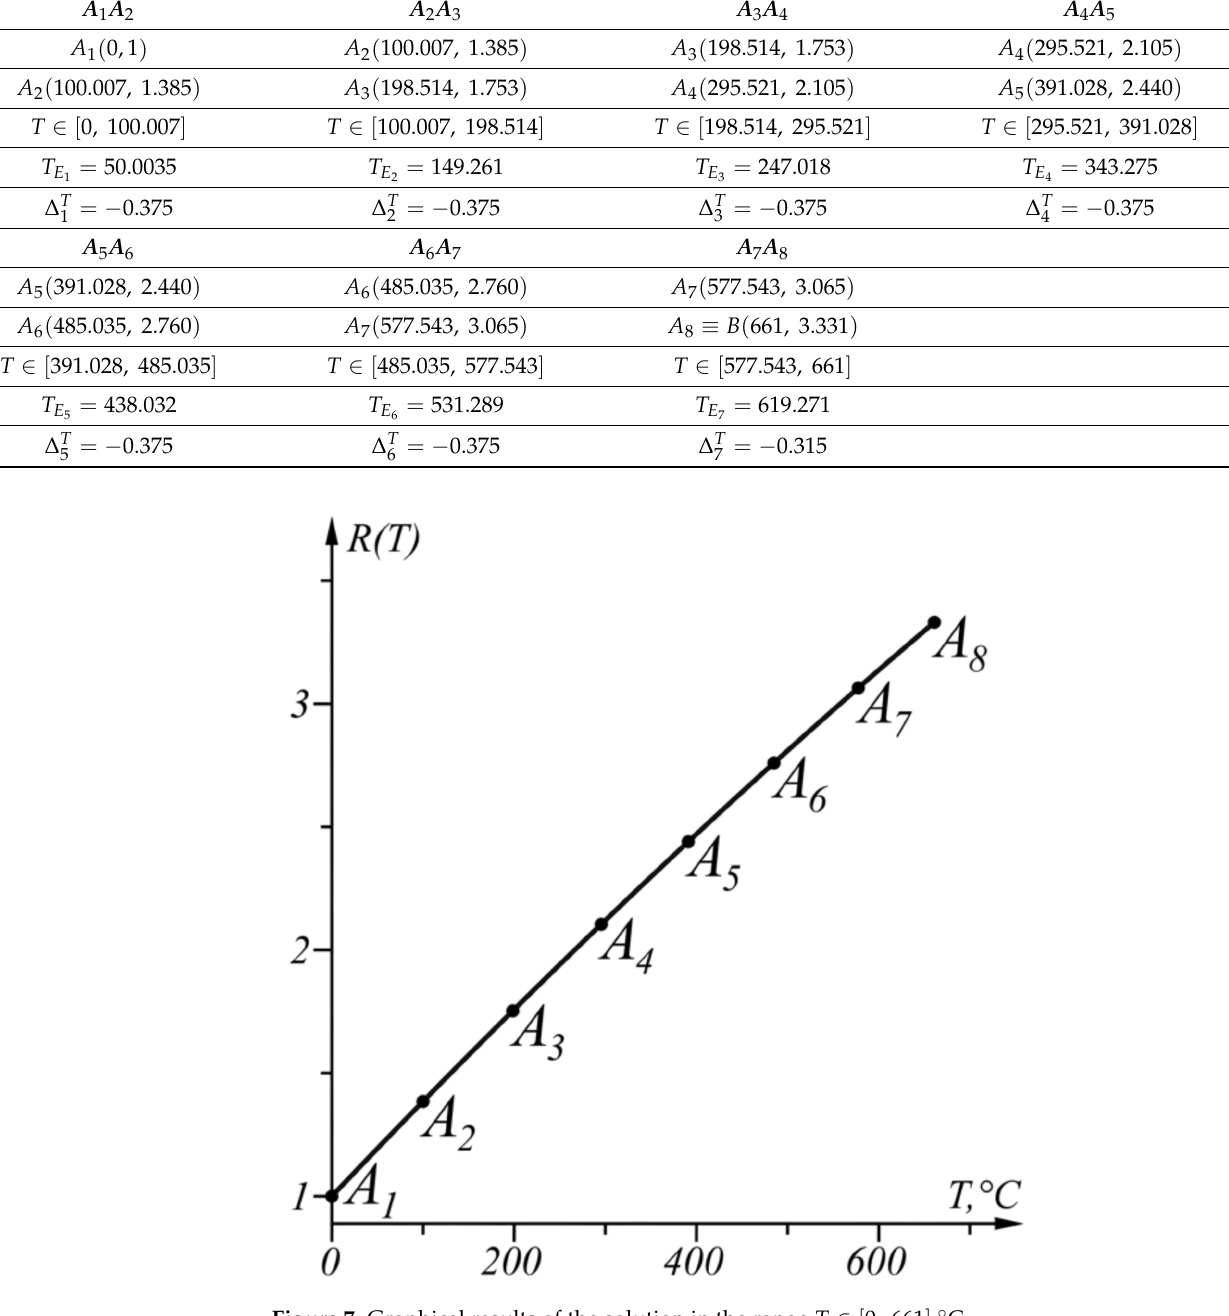
Figure 7. Graphical results of the solution in the range T ∈ [ 0, 661 ] ◦